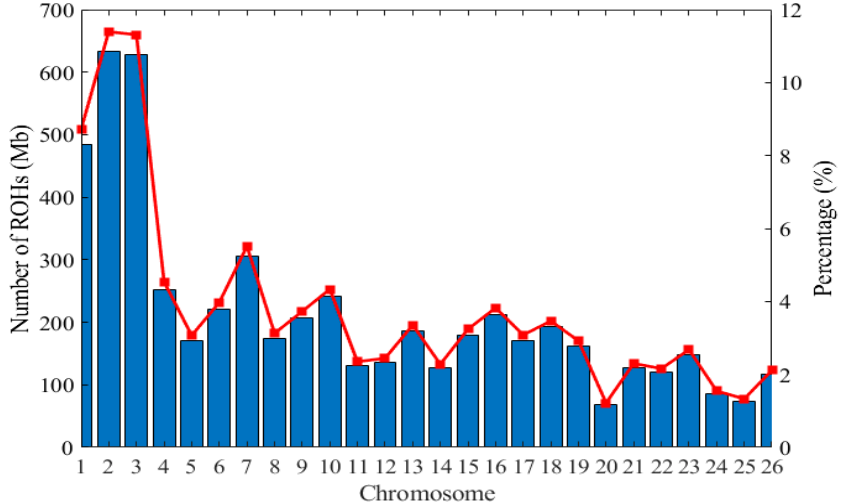
Figure 4. Distribution of the runs of homozygosity across the chromosome in 96 individuals. The X-axis denotes the number of ROHs longer than 1 Mb per chromosome and the Y-axis represents the average percentage (%) of each chromosome covered by ROH (red lines).